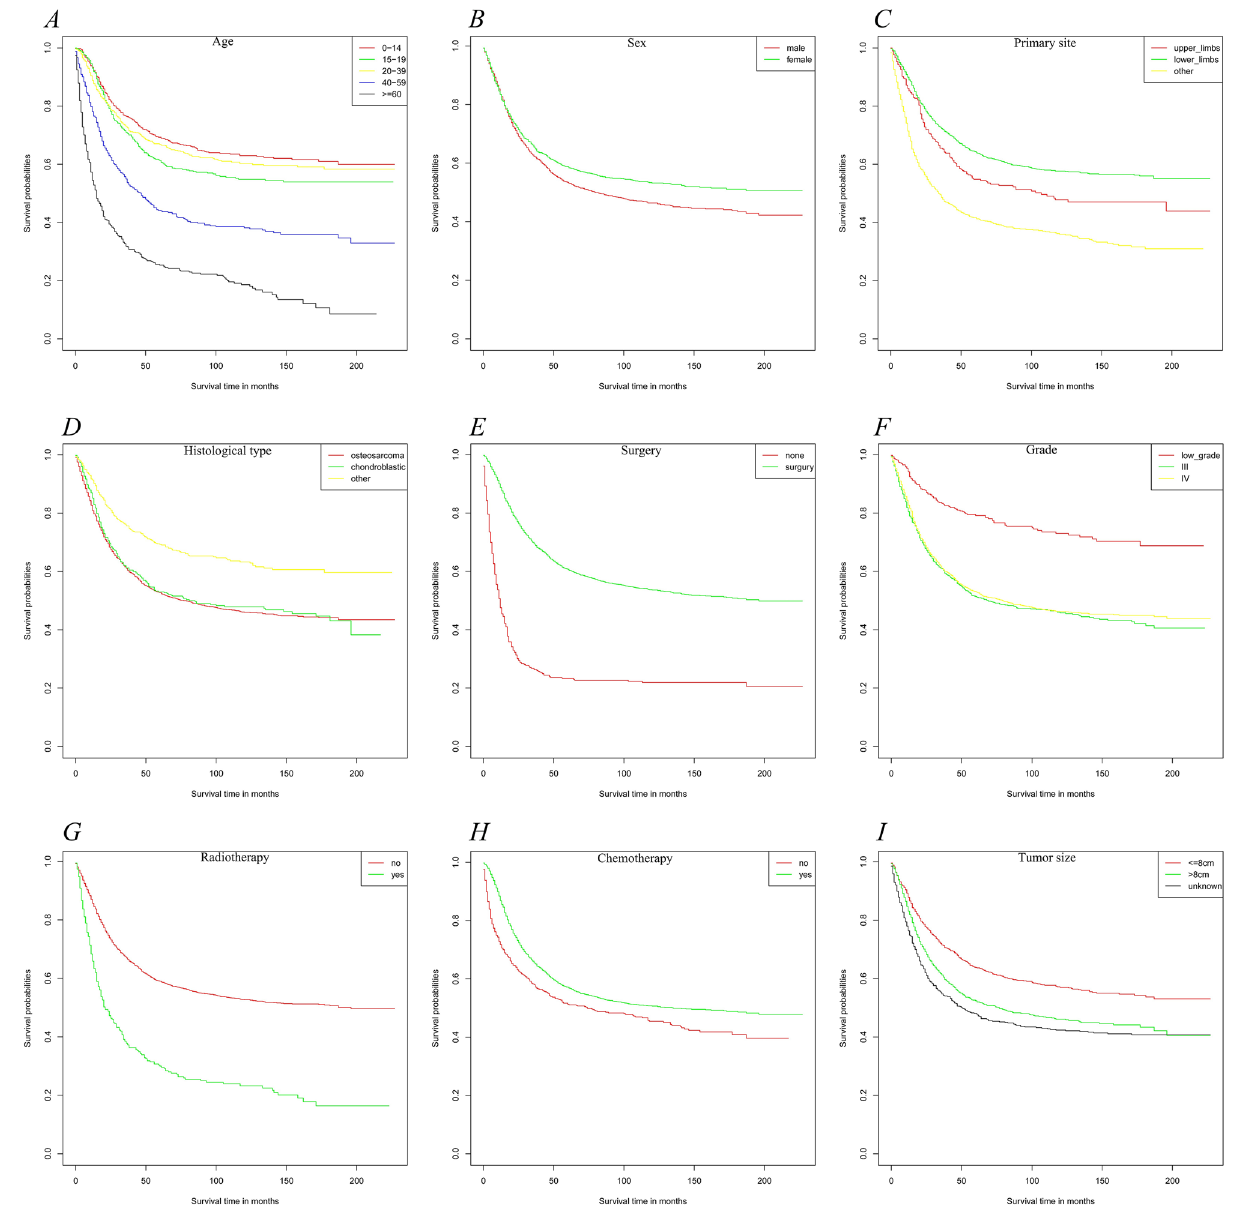
Figure 3. Kaplan–Meier estimated specific survival curve in patients with osteosarcoma stratified by age ( A ), sex ( B ), primary site ( C ), histological type ( D ), surgery ( E ), grade ( F ), radiation ( G ), chemetherapy ( H ), tumor size ( I